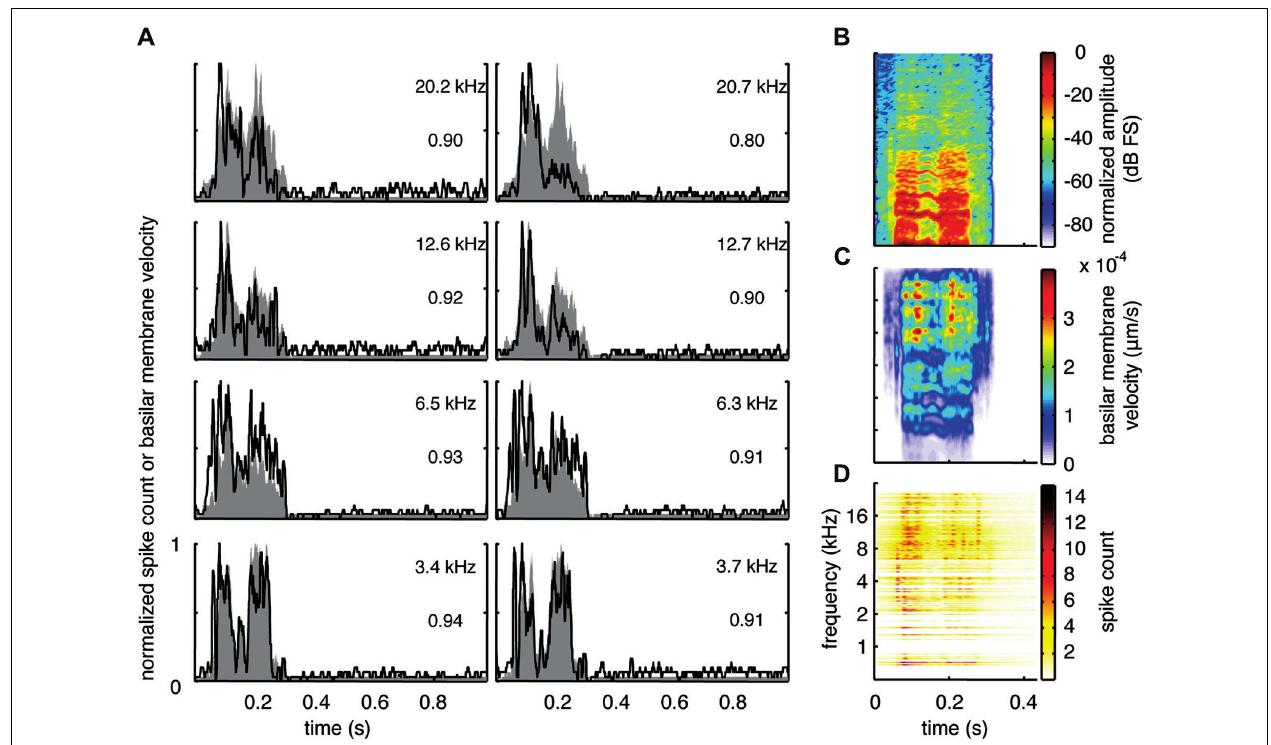
FIGURE 7 | Spectrotemporal representation for BH. Neural activity was recorded across a wide range of best frequency regions from 10 animals and compared to the corresponding frequency-specific DRNL outputs of the stimulus. (A) DRNL outputs and PSTHs for four different frequency laminae (shown in rows) corresponding to two different shanks (shown in columns) from the same recording probe. Black lines correspond to the PSTHs and gray shaded areas correspond to the DRNL outputs.The best frequency and the peak correlation value for each recording site are labeled on the top-right of each plot. (B) Spectrogram of the stimulus using the short-time Fourier